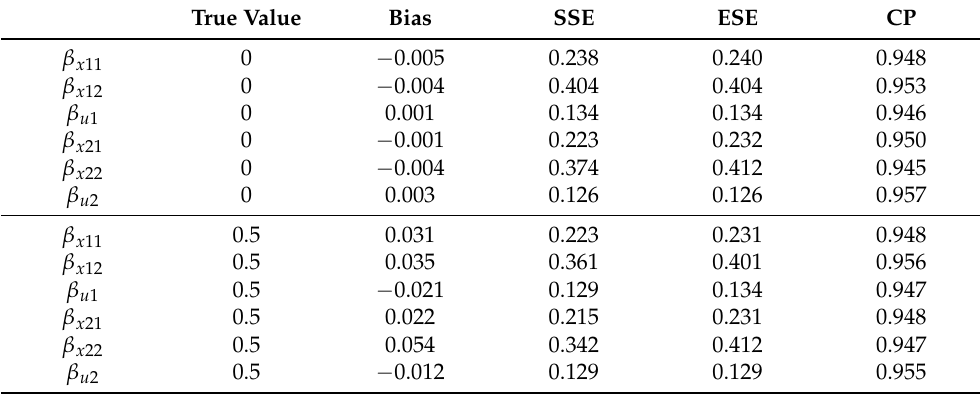
Table 2. Simulation results on estimation of β with the b i ’s generated from the uniform distribution and r 1 = r 2 = 0.